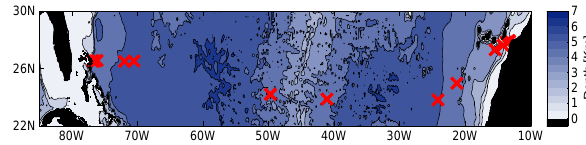
Fig. 1. Distribution of the RAPID/MOCHA moorings across 26.5 ◦ N as deployed for year 2007.